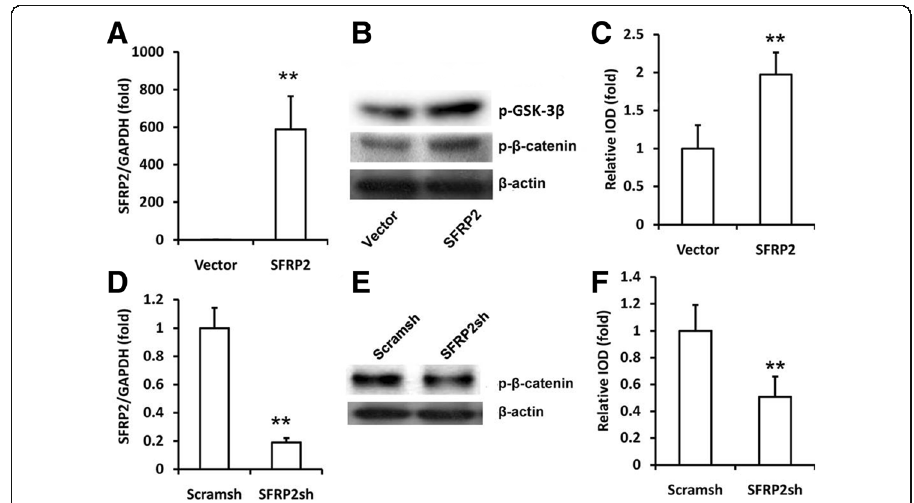
Fig. 1 SFRP2 increased the expression of phosphorylated β -catenin in SCAPs. a Real-time RT-PCR results confirmed the overexpression of SFRP2 via lentivirus infection in SCAPs. GAPDH was used as an internal control. b Western blot results showed that the overexpression of SFRP2 increased the expression of phosphorylated β -catenin and phosphorylated GSK-3 β . Beta-actin was used as an internal control. c Quantitative analysis of phosphorylated β -catenin based on western blot results. d Real-time RT-PCR detection of SFRP2 expression after SCAPs were infected with short hairpin RNAs (shRNA) that silenced SFRP2 ( SFRP2sh ) compared with scrambled shRNA (Scramsh). GAPDH was used as an internal control. e Western blot results showed that depletion of SFRP2 downregulated the expression of phosphorylated β -catenin. f Quantitative analysis of phosphorylated β -catenin based on western blot results. Beta-catenin was used as an internal control. Student ’ s t test was performed to determine statistical significance. All error bars represent SD ( n = 3). ** p ≤